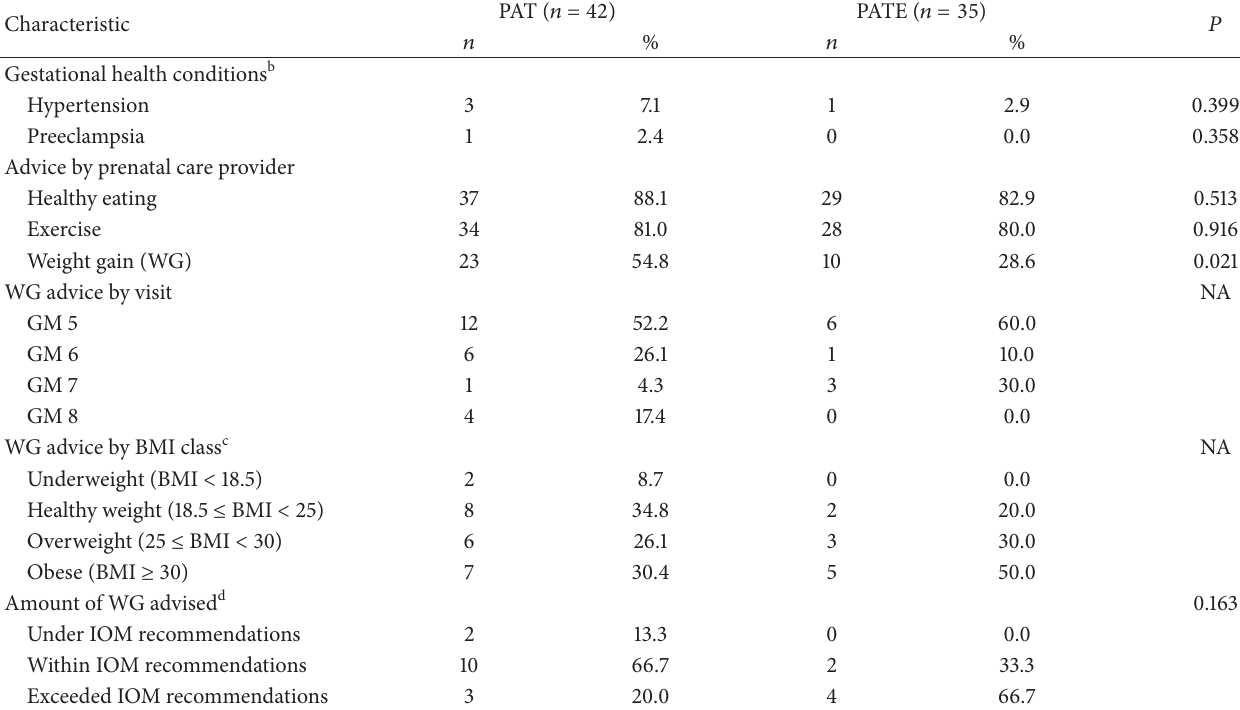
Table 3: Delta Healthy Sprouts participant pregnancy characteristics a by